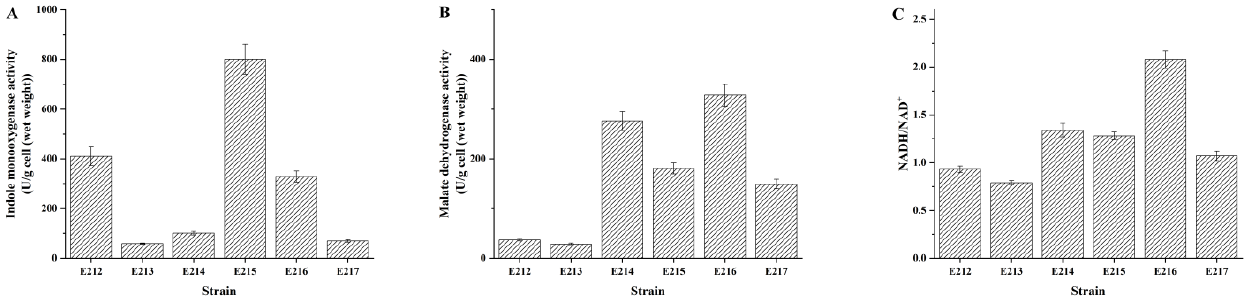
Figure 4. Optimization of the styAB gene and mdh gene by using different promoters, and effects of different levels of IMO activity ( A ), MHD activity ( B ), and NADH/NAD + ( C ) ratio in vivo by engineered E. coli under the fermentation conditions with 2.0 g/L tryptophan as substrate.